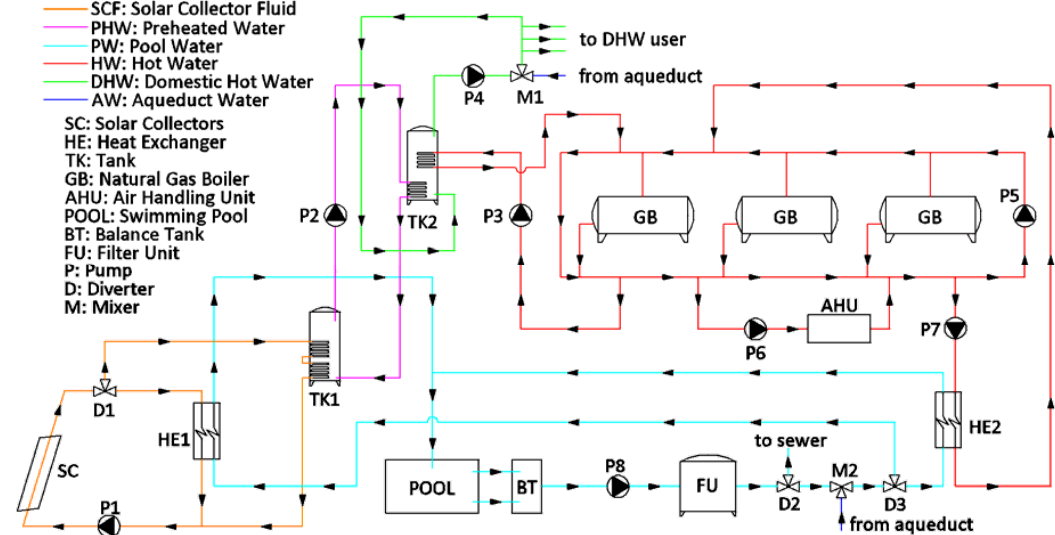
Figure 2. Swimming pool installation scheme.